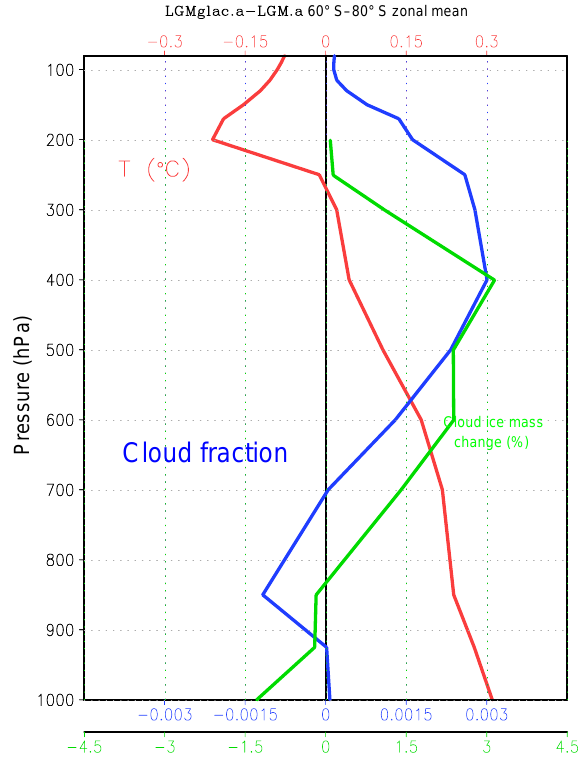
Figure 11. Averaged value height plot (60–80 ◦ S) for change in LGMglac.a–LGM.a for temperature (red), cloud fraction (blue), and cloud ice mass concentration (green). Note that the cloud ice mass concentration is plotted only at values exceeding 1 × 10 − 8 kgkg − 1 in